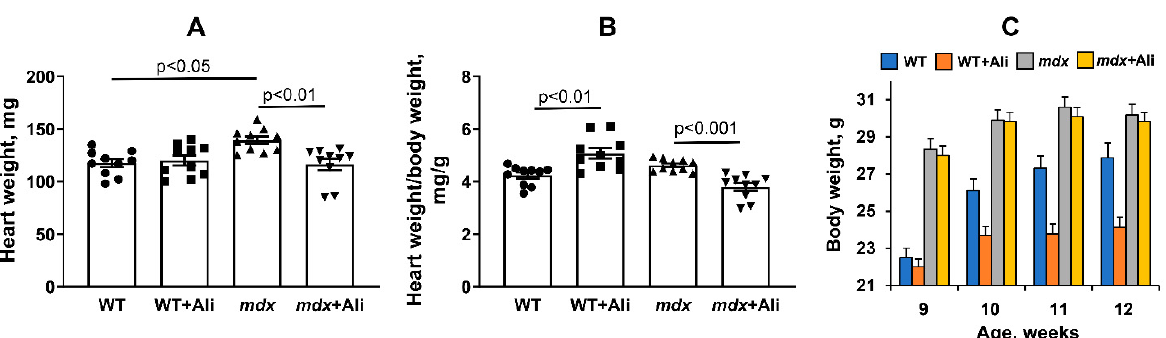
Figure 6. The effect of alisporivir administration on absolute ( A ) and relative heart weight ( B ), as well as on body weight gain ( C ) in experimental groups of mice. The data are presented as means ± SEM ( n = 10).